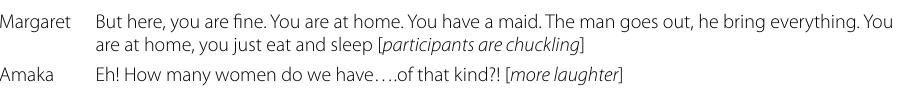
Source: (Mackay 2019a, Table 3,